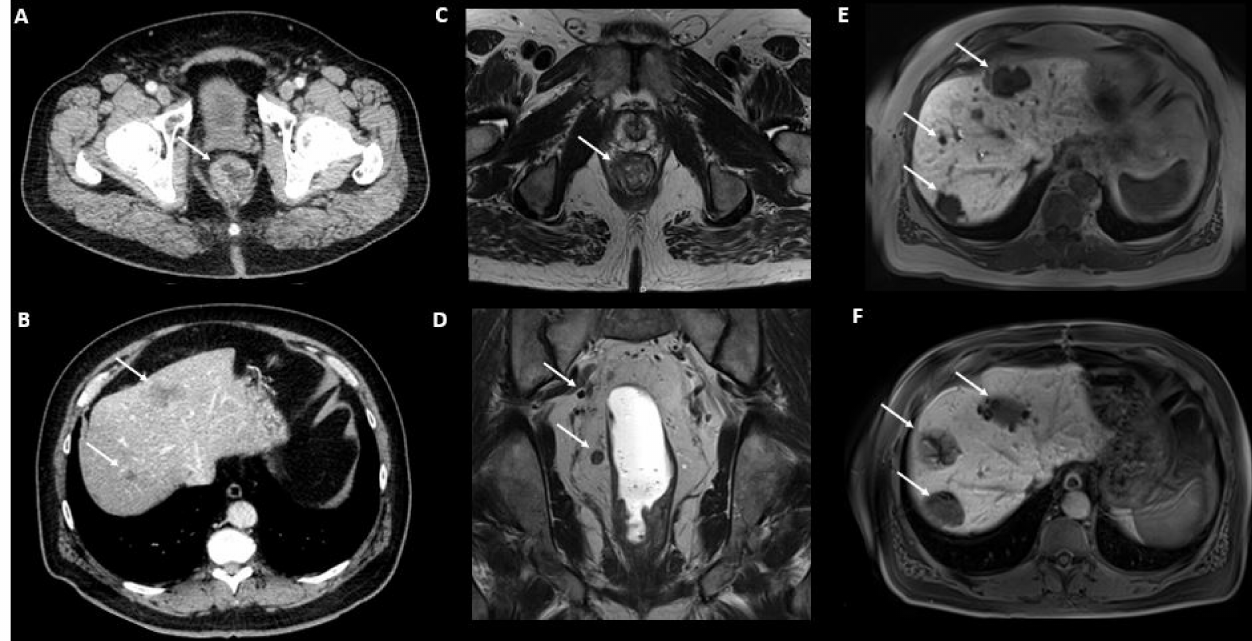
Figure 1. 77-year-old patient presenting with constipation and weight loss, a TAP CECT performed shows a rectal mass ( A , arrow) associated with two liver hypodense lesions in segments II/IVa and VII suspicious of metastases ( B , arrows). No other metastatic site was identified. Rectal MRI for local staging evidences a cT4 cN2 lower rectal tumor invading ipsilateral levator-ani muscle as shown on axial T2 weighted imaging ( C , arrow). Coronal T2 weighted imaging evidenced multiple lymph nodes involving the right mesorectum and the right internal iliac region ( D , arrows). Liver MRI with hepato-specific contrast agent evidenced three liver metastases respectively involving segments II/Iva, VII and VIII ( E , arrows). The patient was considered as oligometastatic and underwent neo- and adjuvant radiochemotherapy, rectal low anterior resection, surgical wedge resection of segments II/IVa, VII and radiofrequency of segment VIII as shown on post-treatment liver MRI ( F , arrows) with no recurrent disease at eight years after diagnosis. Abbreviations: TAP: Thoraco-abdomino-pelvic; CECT: contrast-enhanced